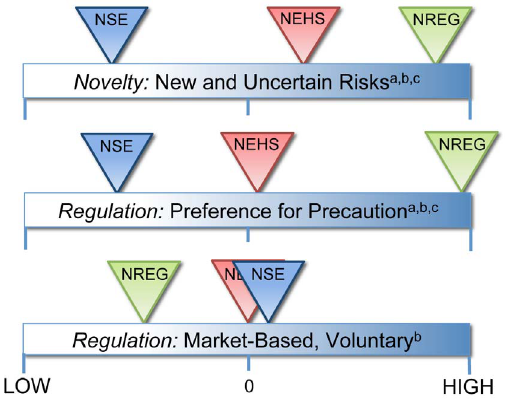
Figure 3. Mean scores for the ’Novelty’ and ’Attitudes toward Regulation’ indices for NSE, NEHS, and NREG groups. The continuum from ‘high’ to ‘low’ represents a factor score range of + / 2 0.5, representing one half standard deviation in either direction from the index. a, b, and c markings indicate significant differences between groups, where a: NSE and NEHS, b: NSE and NREG, c: NEHS and NREG. Tukey HSD post hoc analysis confirms that differences in index scores are significant across all three groups for ‘Novelty’ (p , .05; NSE: N=180, M= 2 0.29, SD=0.86, NREG: N=103, M=0.39, SD=0.88, NEHS: N=121, M=0.11, SD=0.85), and for ‘Regulation: Preference for Precaution’ (p , .001; NSE: N=180, M= 2 0.29, SD=0.82; NEHS: N=121, M=0.06, SD=0.93; NREG: N=103, M=0.43, SD=0.81). Post hoc analysis confirmed a significant difference between NSE and NREG groups only for ‘Regulation: Market-Based, Voluntary’ (p , .022; NSE: N=180, M= 2 0.08, SD=0.80; NREG: N=103, M= 2 0.21, SD=0.91).